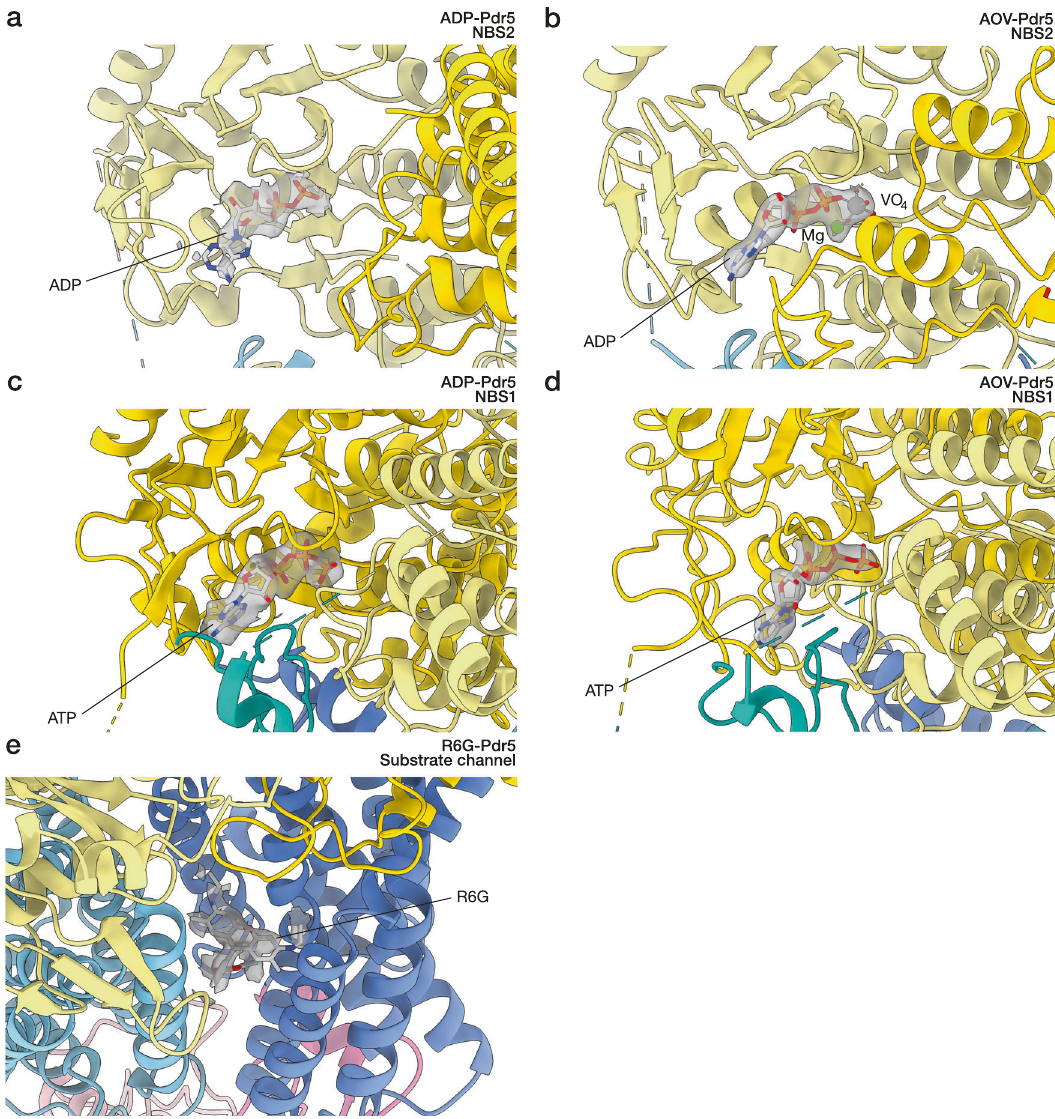
Fig. 4 and Supplementary Fig. 10). The domain colouring follows the scheme of the previous fi gures. a The catalytic site (NBS2) of Pdr5 in inward-facing conformation (ADP-Pdr5) with bound ADP. b The catalytic site of outward-facing Pdr5 (AOV-Pdr5) in a vanadate-trapped state that mimics the intermediate step of hydrolysis with an ADP-orthovanadate molecule. Vanadium is shown as a grey sphere and co-ordinated magnesium ion is depicted as a green sphere. c The deviant, inactive site (NBS1) of Pdr5 in the inward-facing conformation (ADP-Pdr5), showing the bound ATP. d The same site in the outward-facing conformation